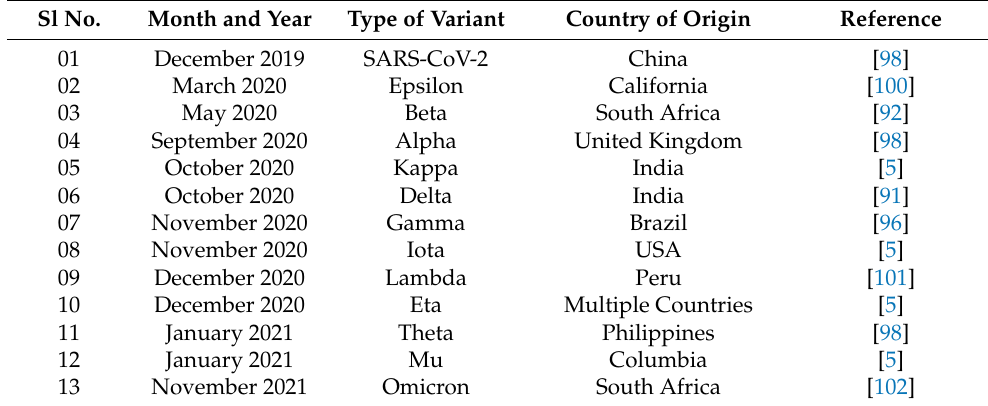
Table 1. Timeline of occurrence of various key events related to the SARS-CoV-2 outbreak. Sl